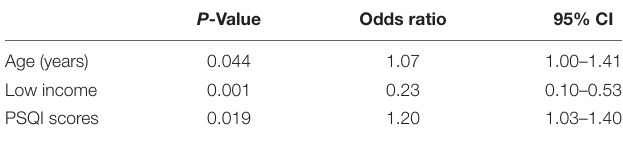
TABLE 2 | Multiple logistic regression analysis for factors independently associated with global cognition in insomnia